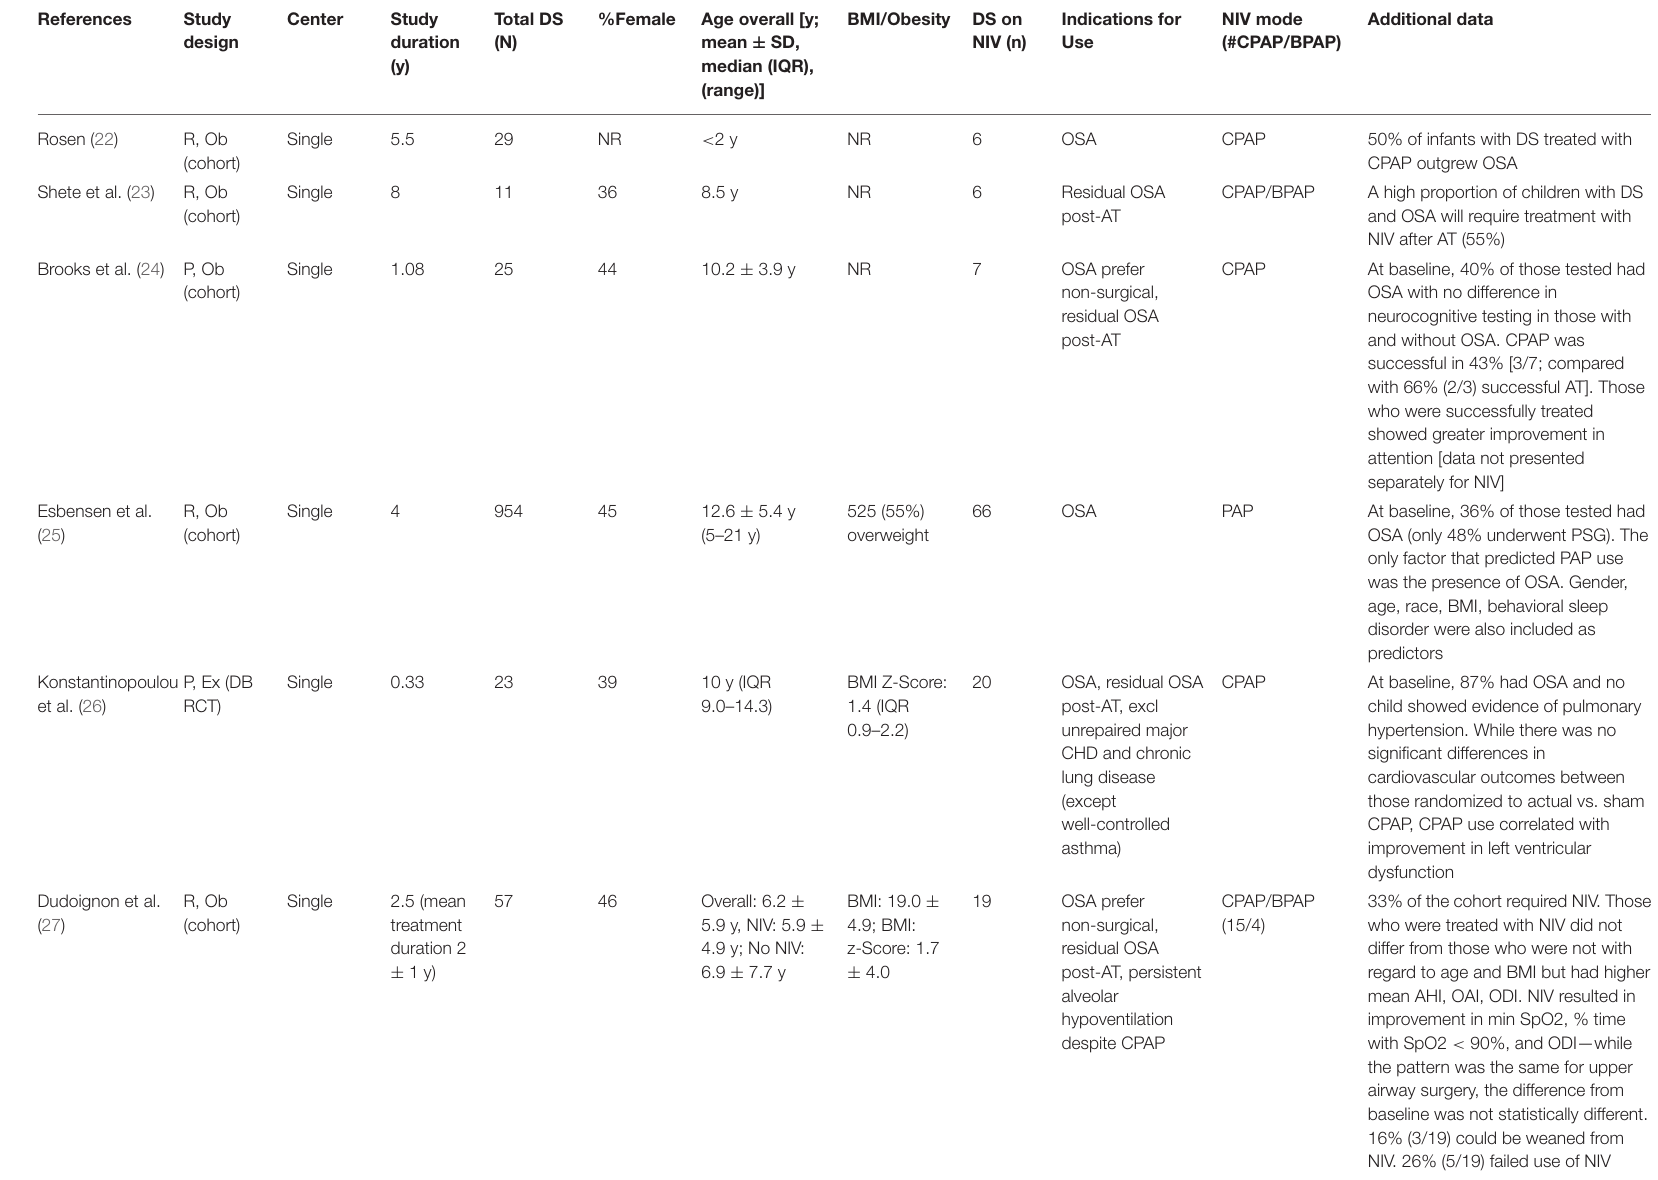
TABLE 2 | Summary of studies exclusively on children with Down syndrome using long-term non-invasive